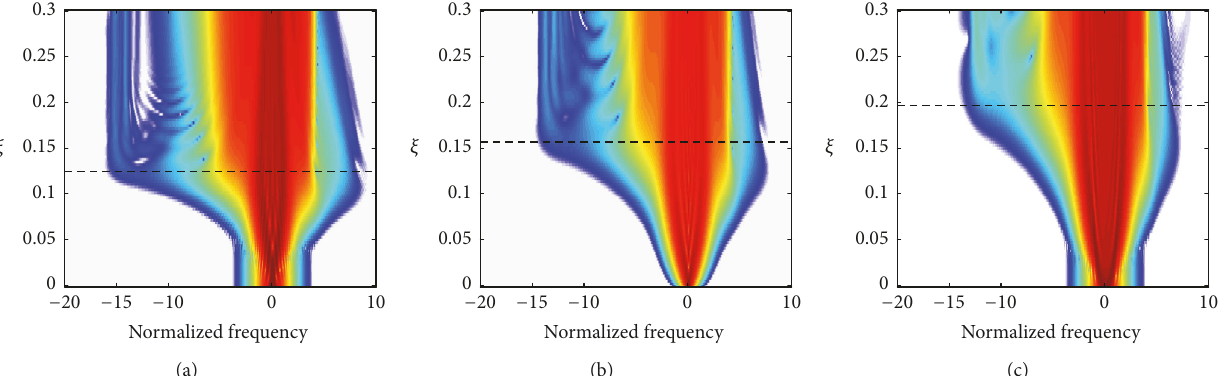
Figure 5: Pulse spectral evolution during propagation for different input pulse chirps, (a) 𝐶 = −2 , (b) 𝐶 = 0 , and (c) 𝐶 = 2 as the sign of TOD is positive. The black horizontal dash line indicates the position at which the maximum spectral broadening occurs, that is, the DW generated.